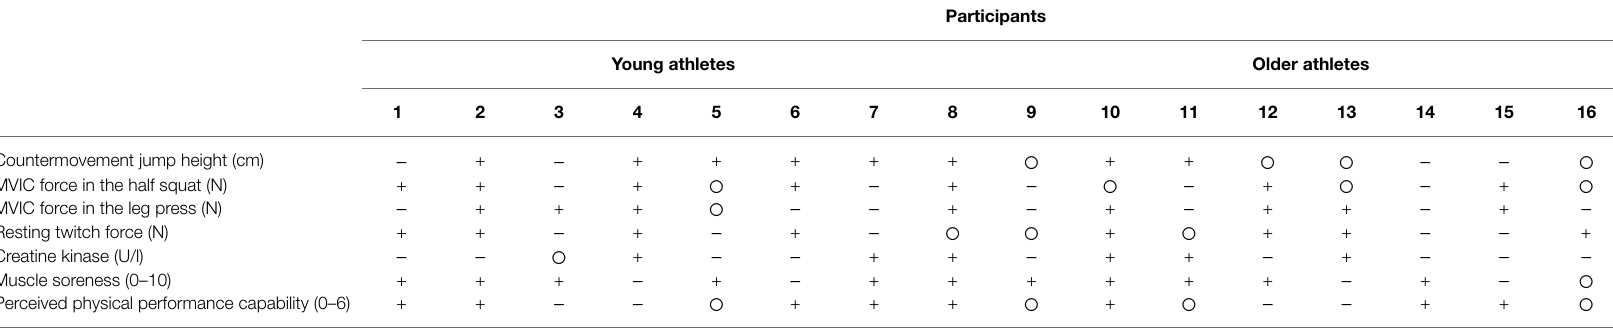
TABLE 3 | Individual net effect differences between a mixed-method recovery (MMR) intervention and a passive recovery (PAS) on selected markers between post-training and post-48 measures.